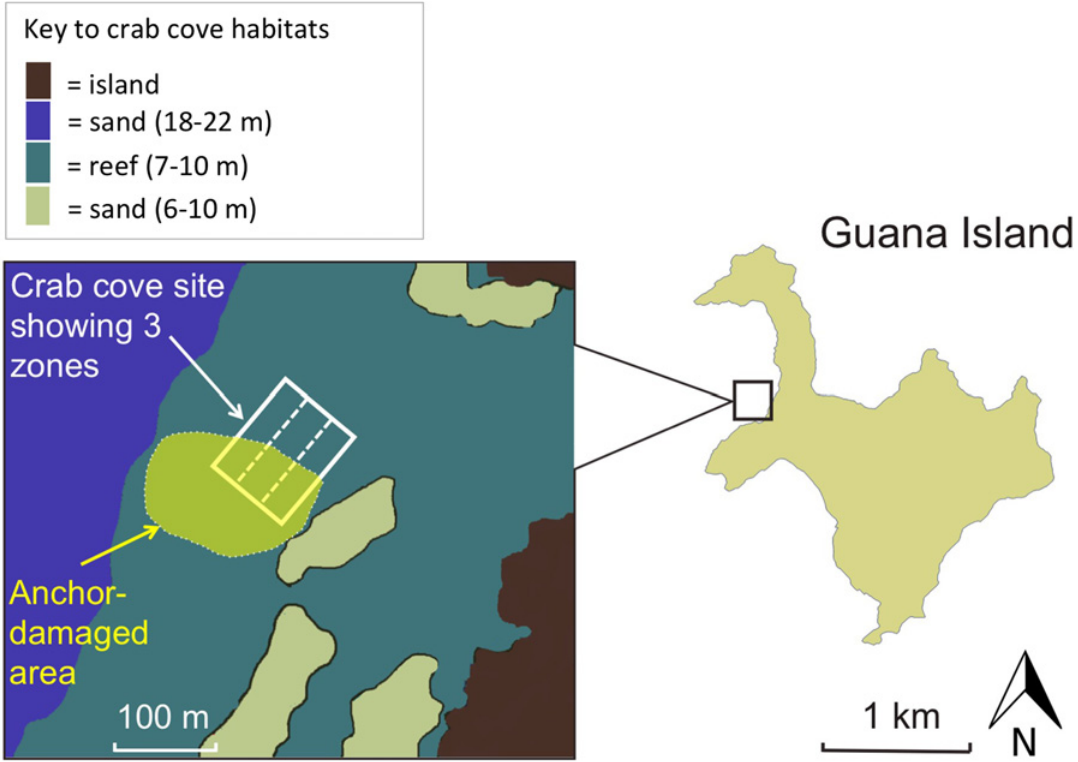
Fig 2. A map of the Crab Cove study site near Guana Island, British Virgin Islands. The image of Crab Cove shows the portion of the site damaged by the one-off anchoring event in 2004, and the three zones within the site that are used to account for the offshore gradient in reef structure. doi:10.1371/journal.pone.0144498.g002 PLOS ONE | DOI:10.1371/journal.pone.0144498 December 30,